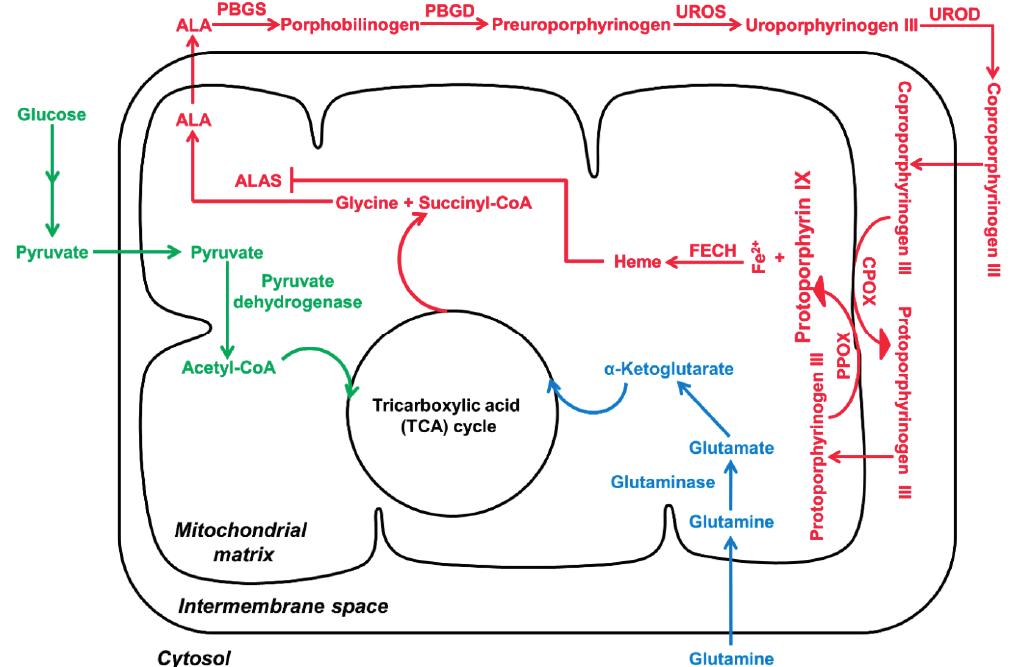
Figure 1. Heme biosynthesis pathway (in red) connects with glucose (in green) and glutamine (in blue) metabolic pathways. Porphyrin synthesis converges with energy metabolism through TCA (tricarboxylic acid) cycle. Enhanced glycolysis and glutaminolysis in tumor cells may activate heme biosynthetic pathway to ensure energy production and avoid the accumulation of TCA